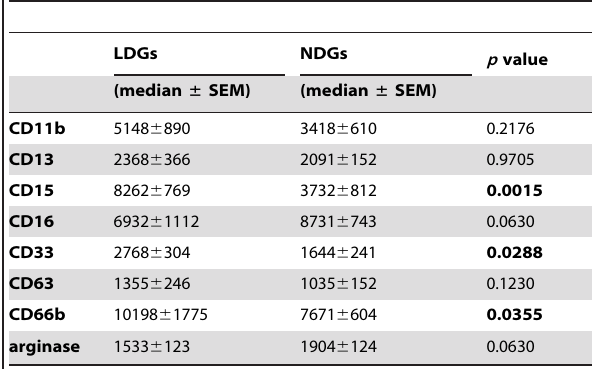
Table 6. LDGs: Correlation between CD4 + T cell counts and MFIs.